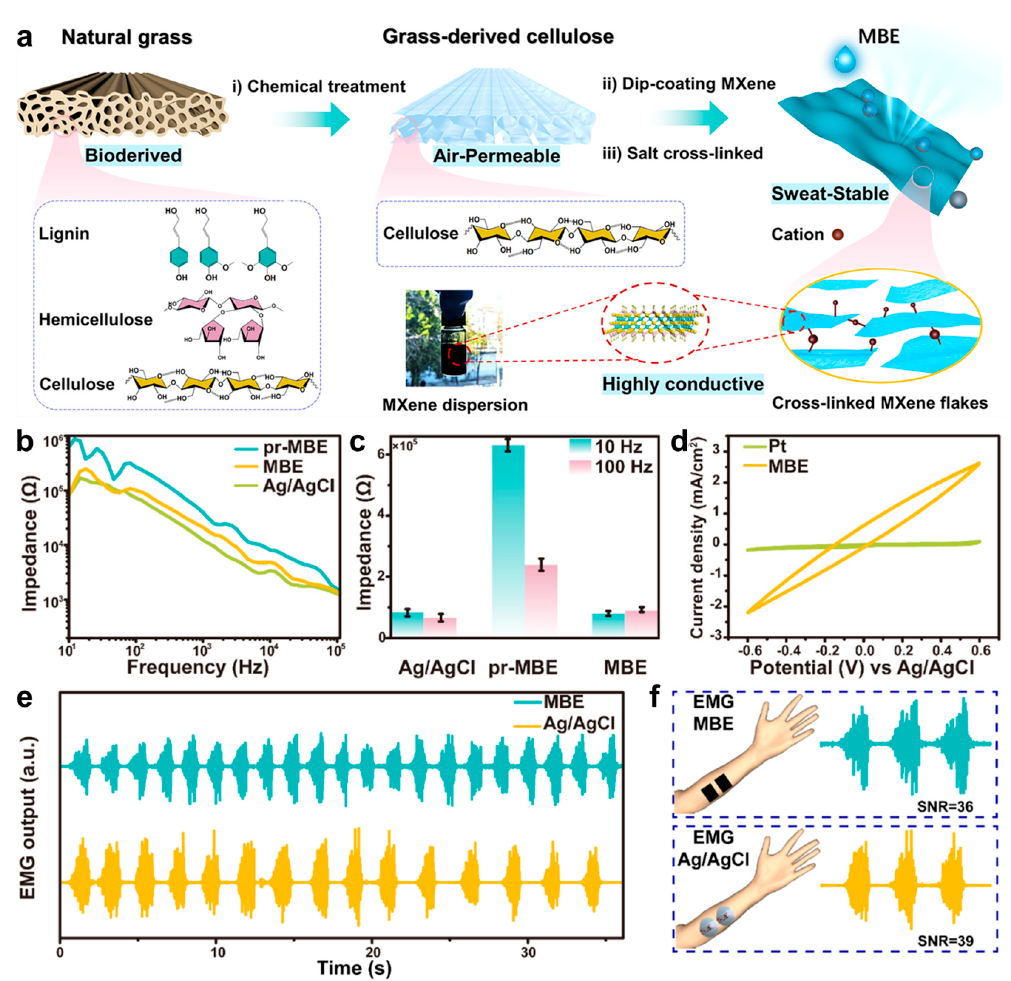
Figure 4. Fabrication procedures, performance characterization and application illustration of MXene-based electrodes (MBE). ( a ) Preparation process of MBE. ( b ) Contact impedances between skin and different electrodes, including pr-MBE, MBE and Ag/AgCl. ( c ) Comparison of impedance values between pr-MBE, MBE and Ag/AgCl electrodes at 10 and 100 Hz. ( d ) Cyclic voltammetry curves for Pt and MBE electrodes. ( e ) EMG signals recorded by Ag/AgCl and MBE electrodes. ( f ) Schematic illustration of MBE and Ag/AgCl electrodes attached on the arm for EMG measuring and the corresponding SNR values for two electrodes [123].